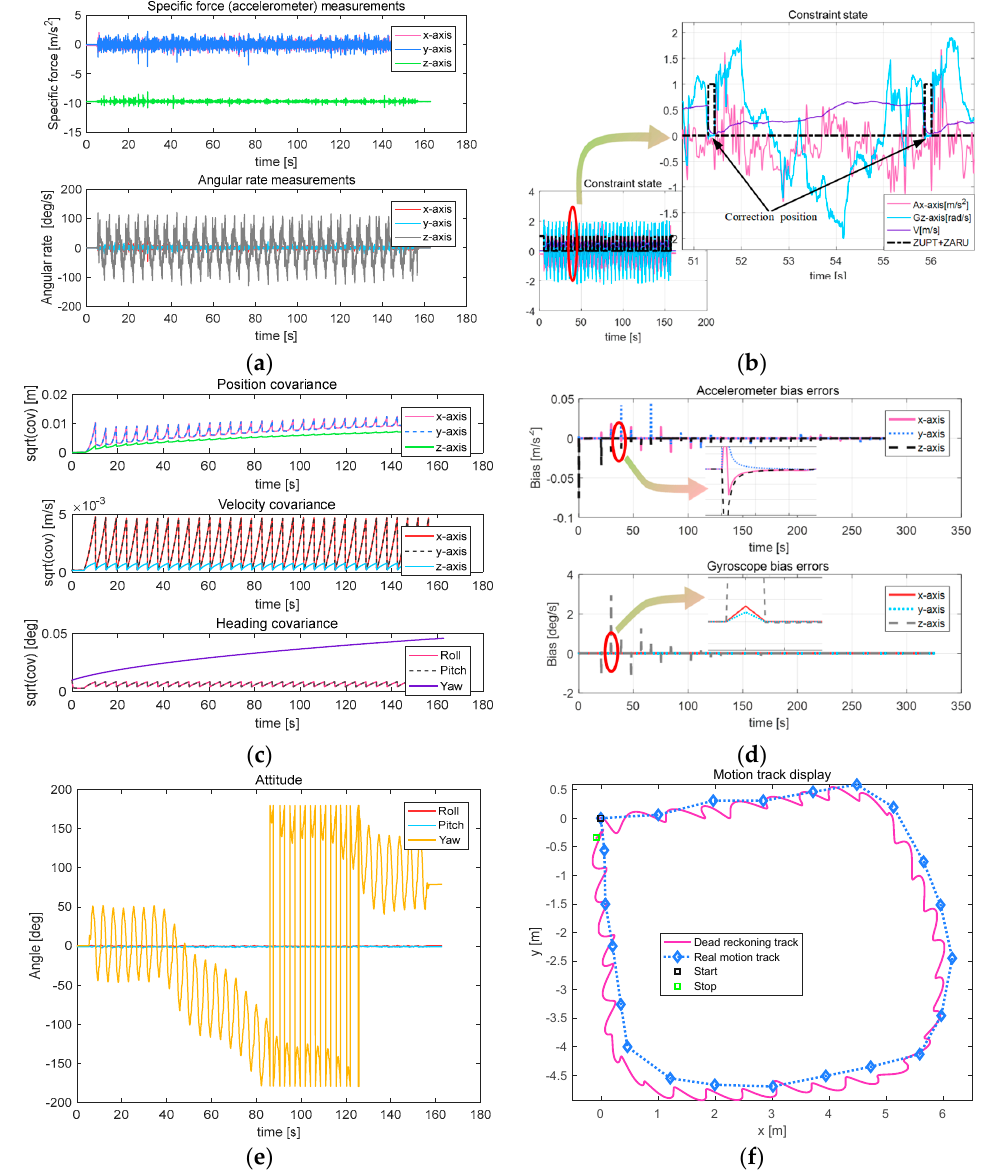
Figure 17. Parameters related to circular motion. ( a ) Output result of the MEMS IMU; ( b ) Constraint state; ( c ) Result of the covariance; ( d ) Bias errors; ( e ) Attitude of the snake robot; ( f ) Moving path of the snake robot.